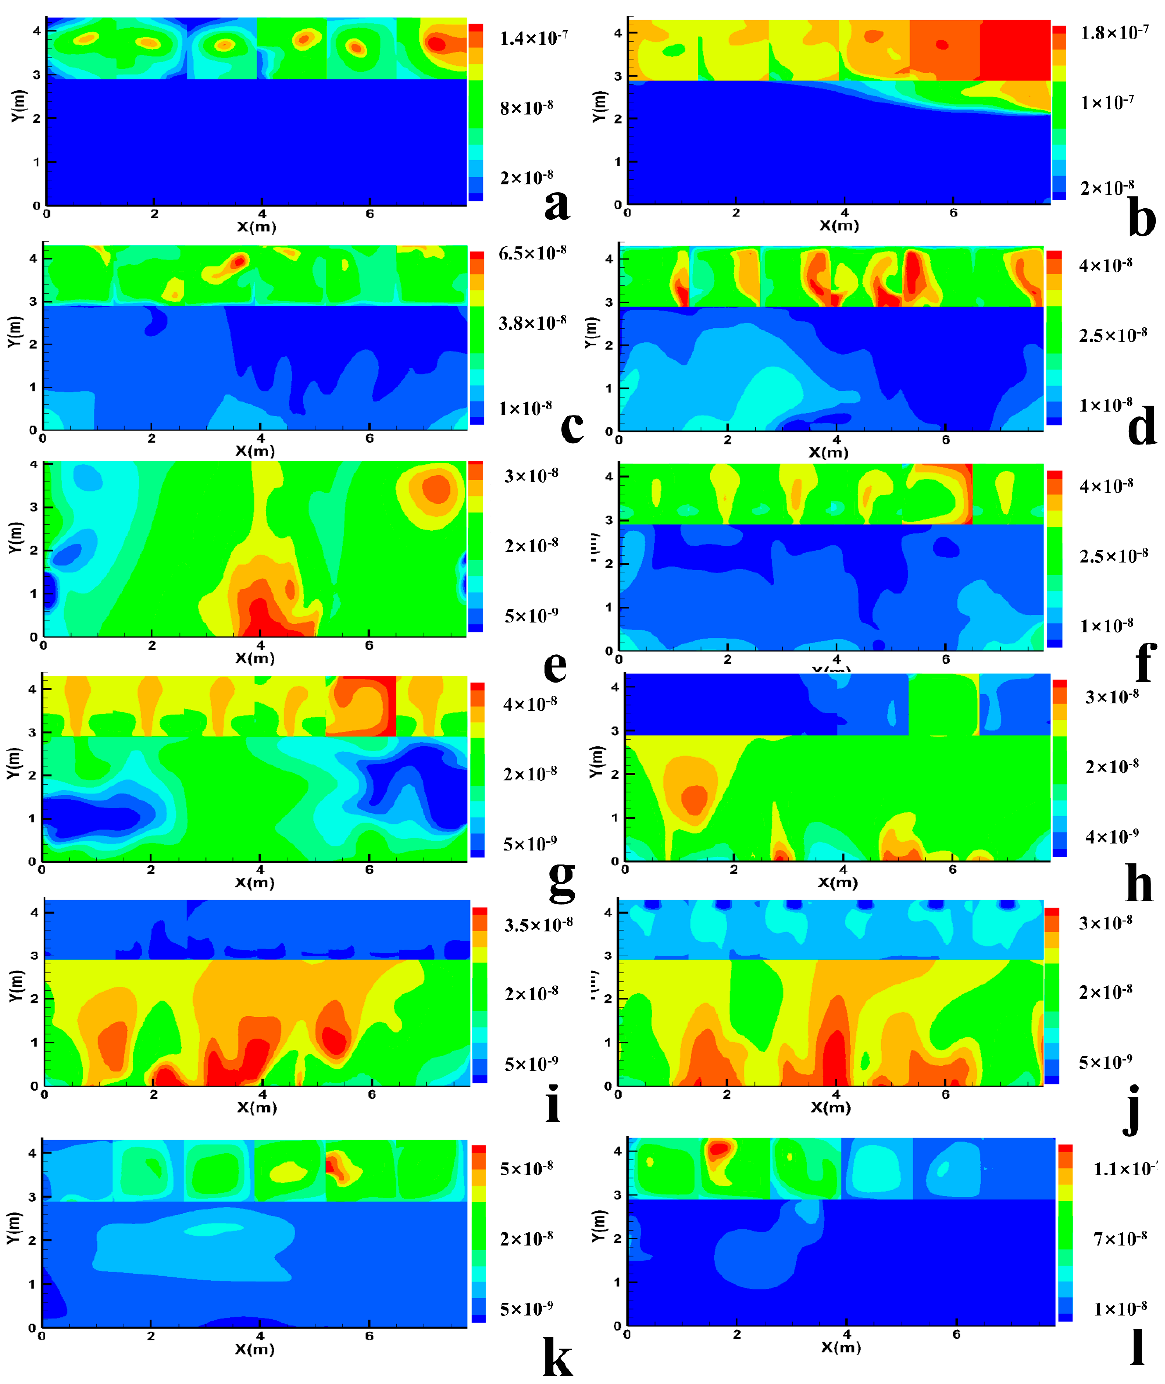
Figure 9. Hydrogen sulfide concentration distribution for different cases (Z = 1.5 m, ACH = 15): ( a – l ) MV-1–IJV-7.